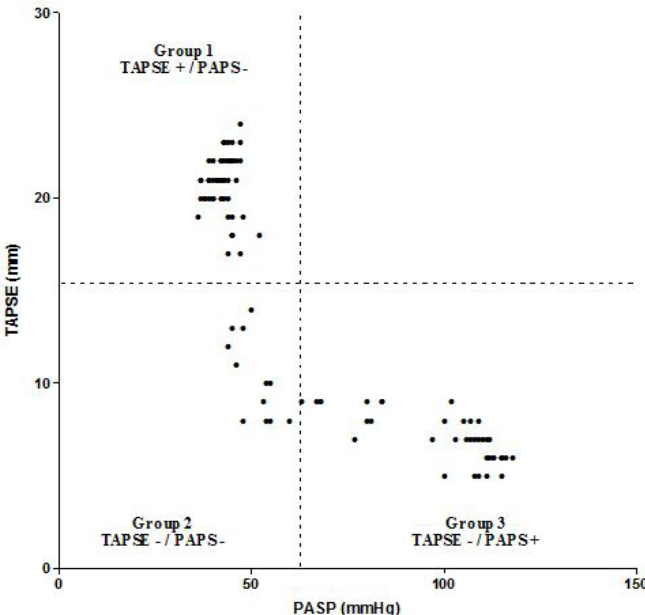
Figure 2. Distribution of patients according to tricuspid annular plane systolic excursion (TAPSE) and pulmonary artery systolic pressure (PASP) values at the admission. Dotted lines represent the mean values of TAPSE and PASP and divide the population in 3 Groups.